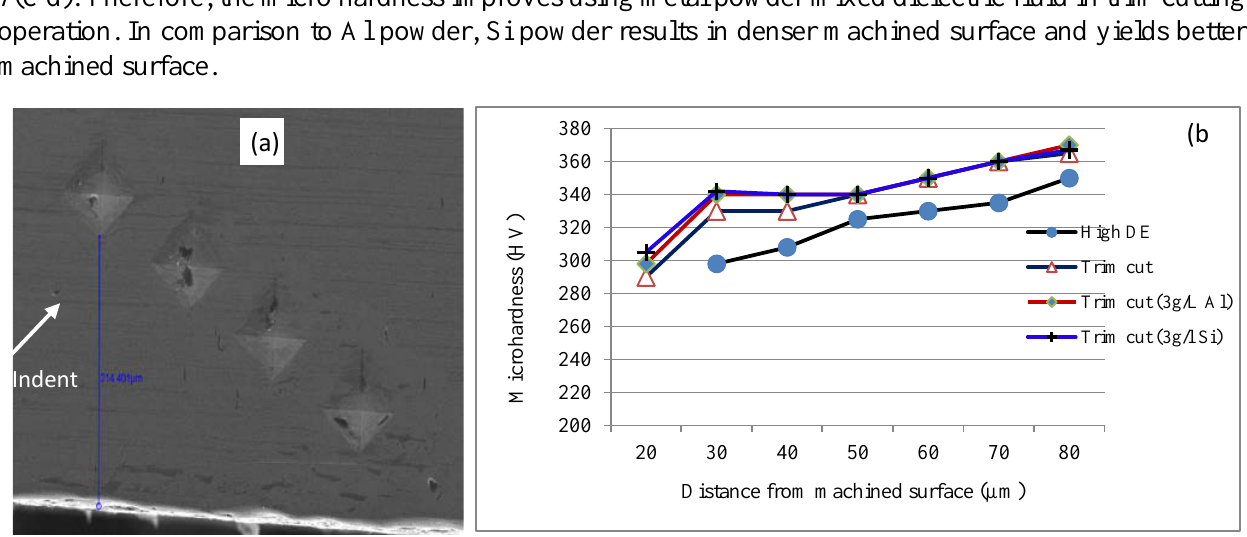
Fig. 9 (a) Micro indent on transverse surface (b) Comparison of micro-hardness underneath the machined surface under different process